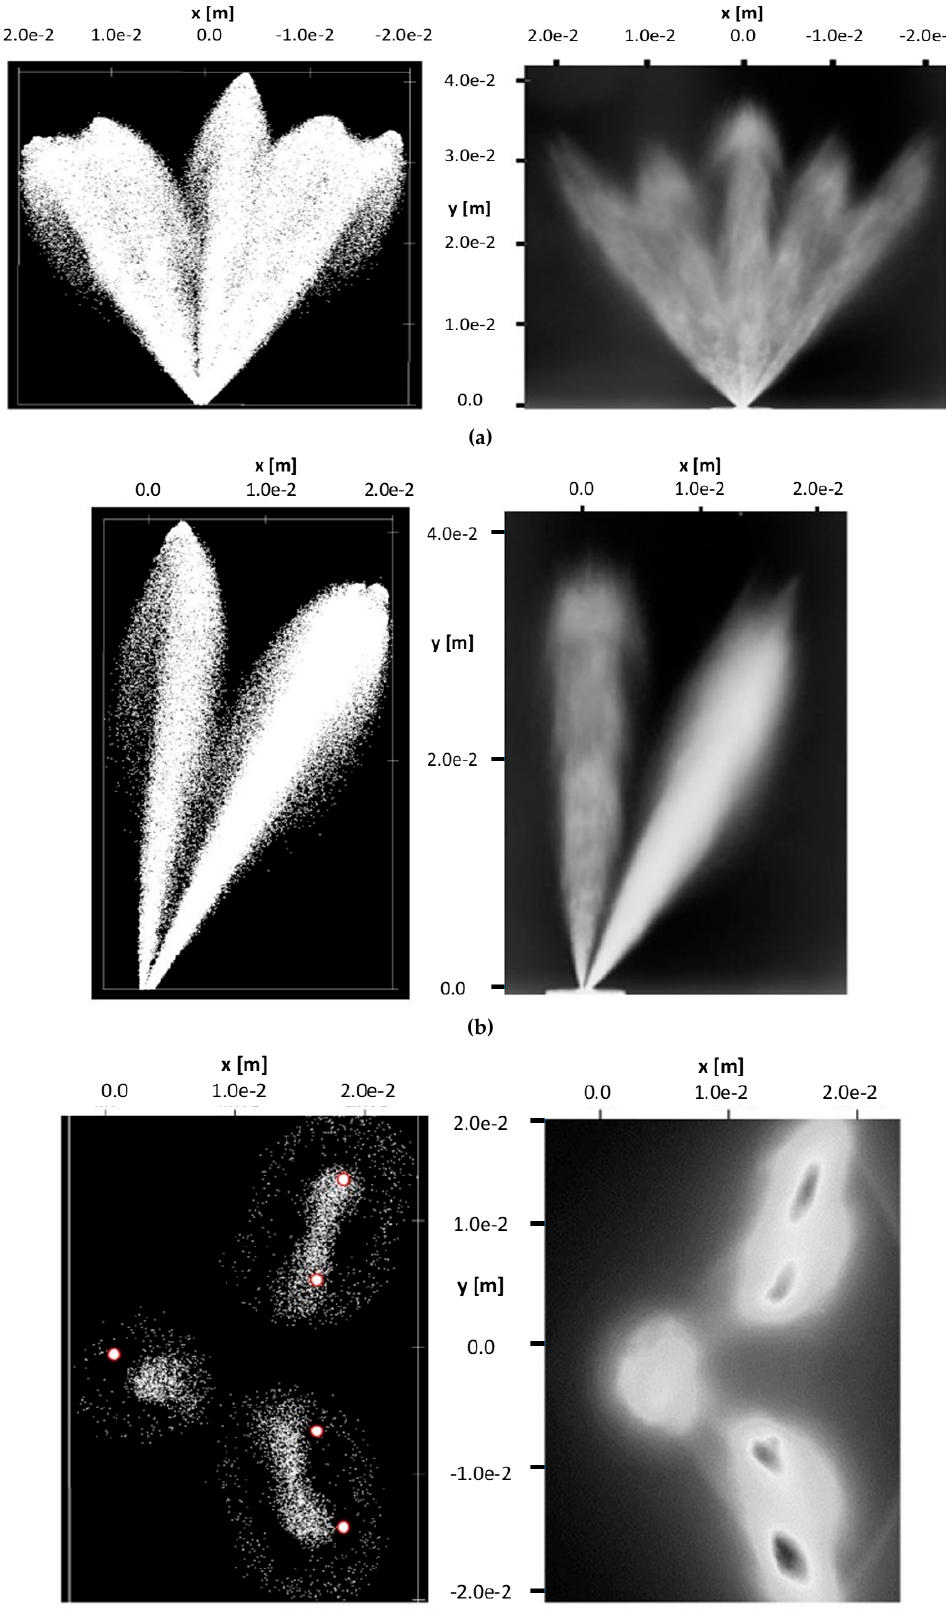
Figure 4. Comparison of spray simulations (left) and experimental imaging (right) at 0.5 ms from SOI: front ( a ), side ( b ) and bottom view at 30 mm from the injector tip ( c ). Conditions as in Table 4.